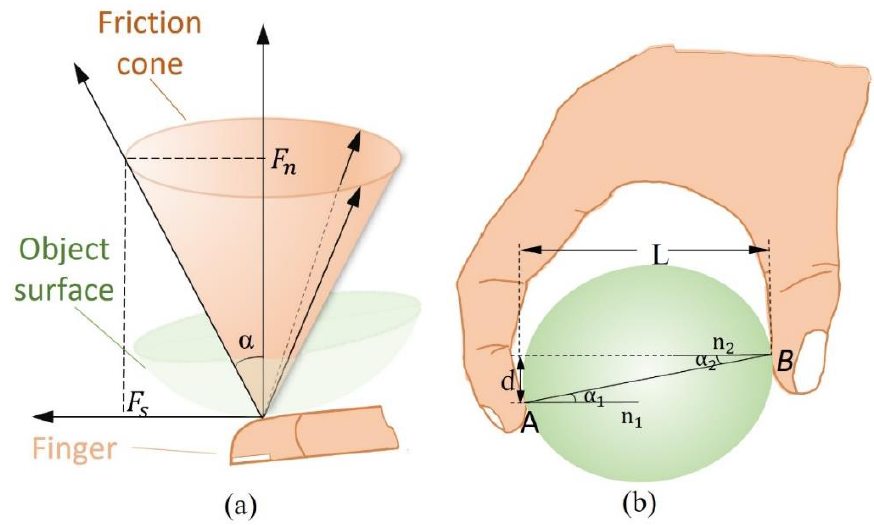
Figure 2. Friction cone and the two-finger grasping model. ( a ) Schematic representation of the friction cone in grasping. ( b ) The two-finger grasping model. The above formula indicates that the static friction force at the contact point must be on the surface or inside of the friction cone, and the angle (friction angle) between the full binding force and the normal binding force is maximum when it is located on the surface. Additionally, the friction angle satisfies: